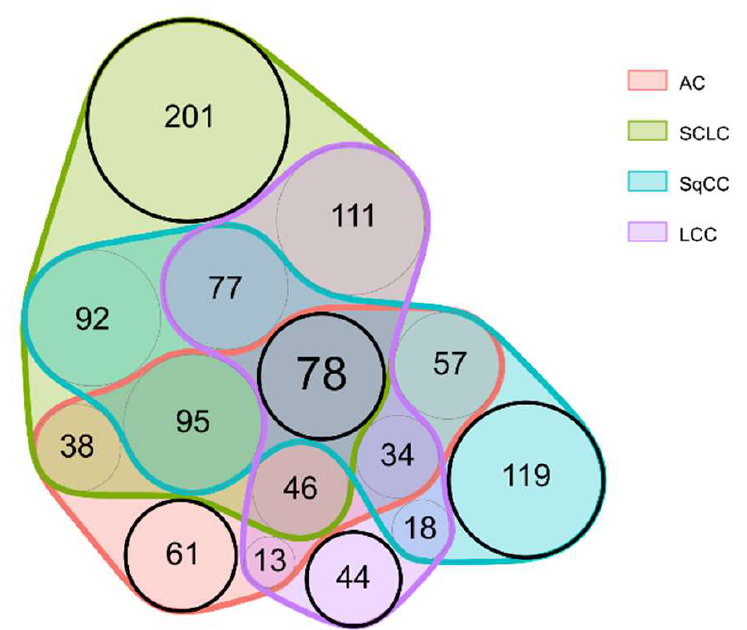
Figure 3. Venn diagram displaying the proteins differentially expressed in the different LC types compared to adjacent tissue.